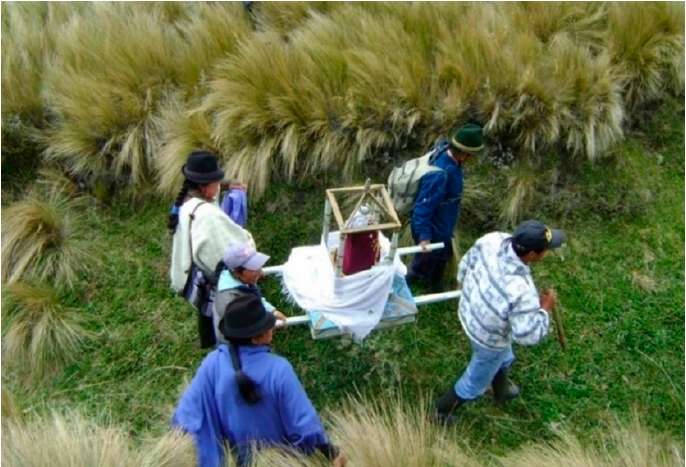
Figure 6. The Wachakaray or request for rain to the páramo , a syncretic ceremony.